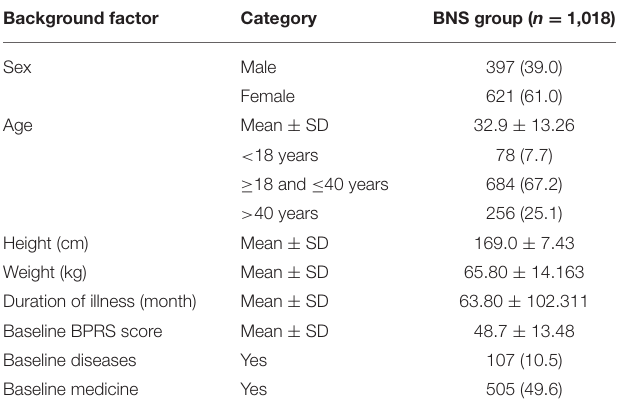
TABLE 1 | Demographics of the patients with schizophrenia.